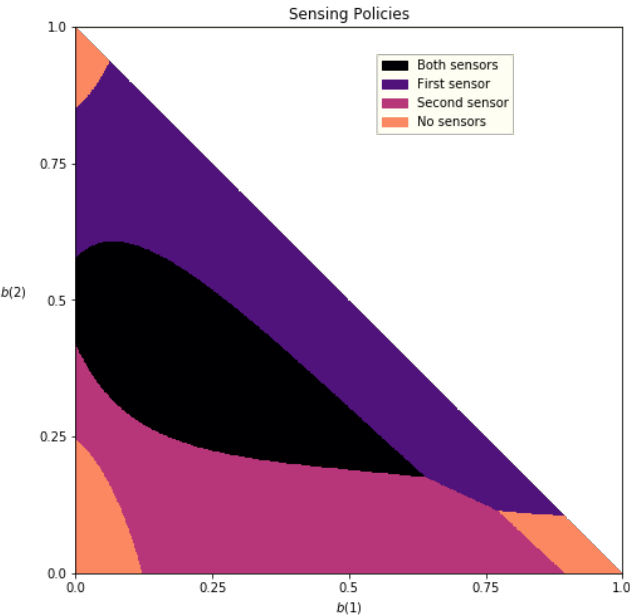
Figure 10. Greedy sensing policy over the belief state space b . Since b 3 = 1 − ( b 1 + b 2 ) , the belief space forms a simplex and may be described by only the belief over the first two states.